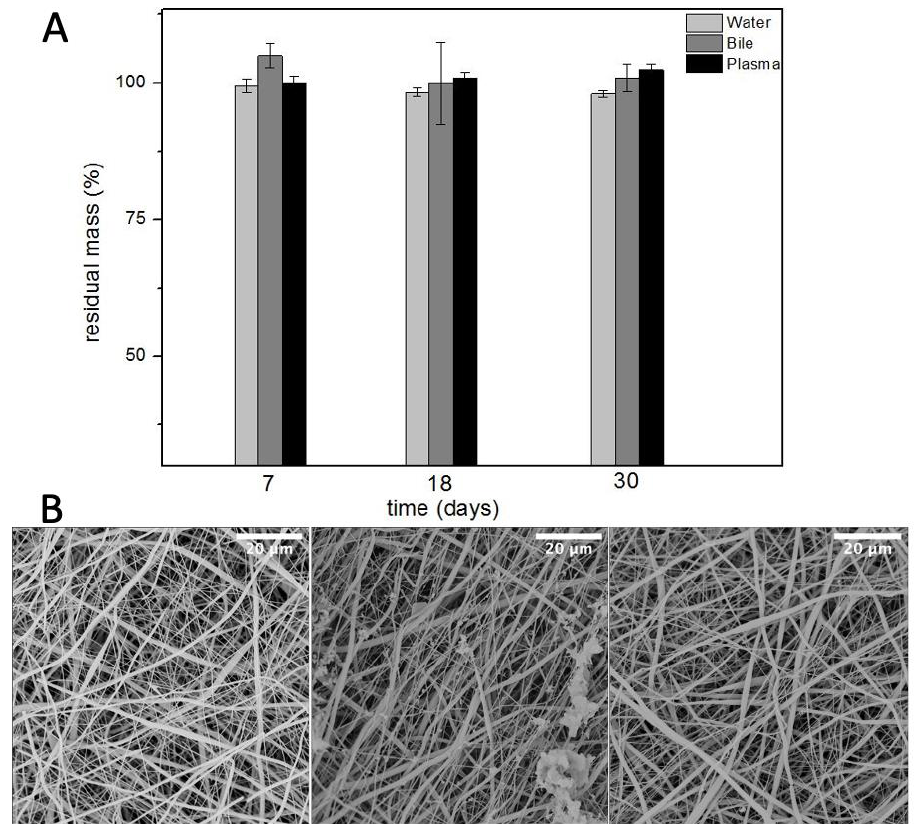
Figure 5. Residual mass ( A ) and SEM micrographs ( B ) of electrospun PBS after degradation in water (left), bile (centre), and plasma (right) ( n = 5).